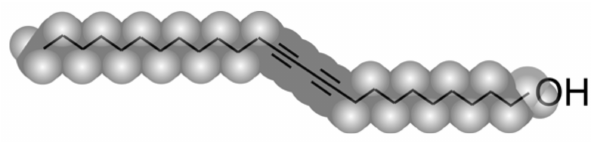
Figure 1. Molecular structure of